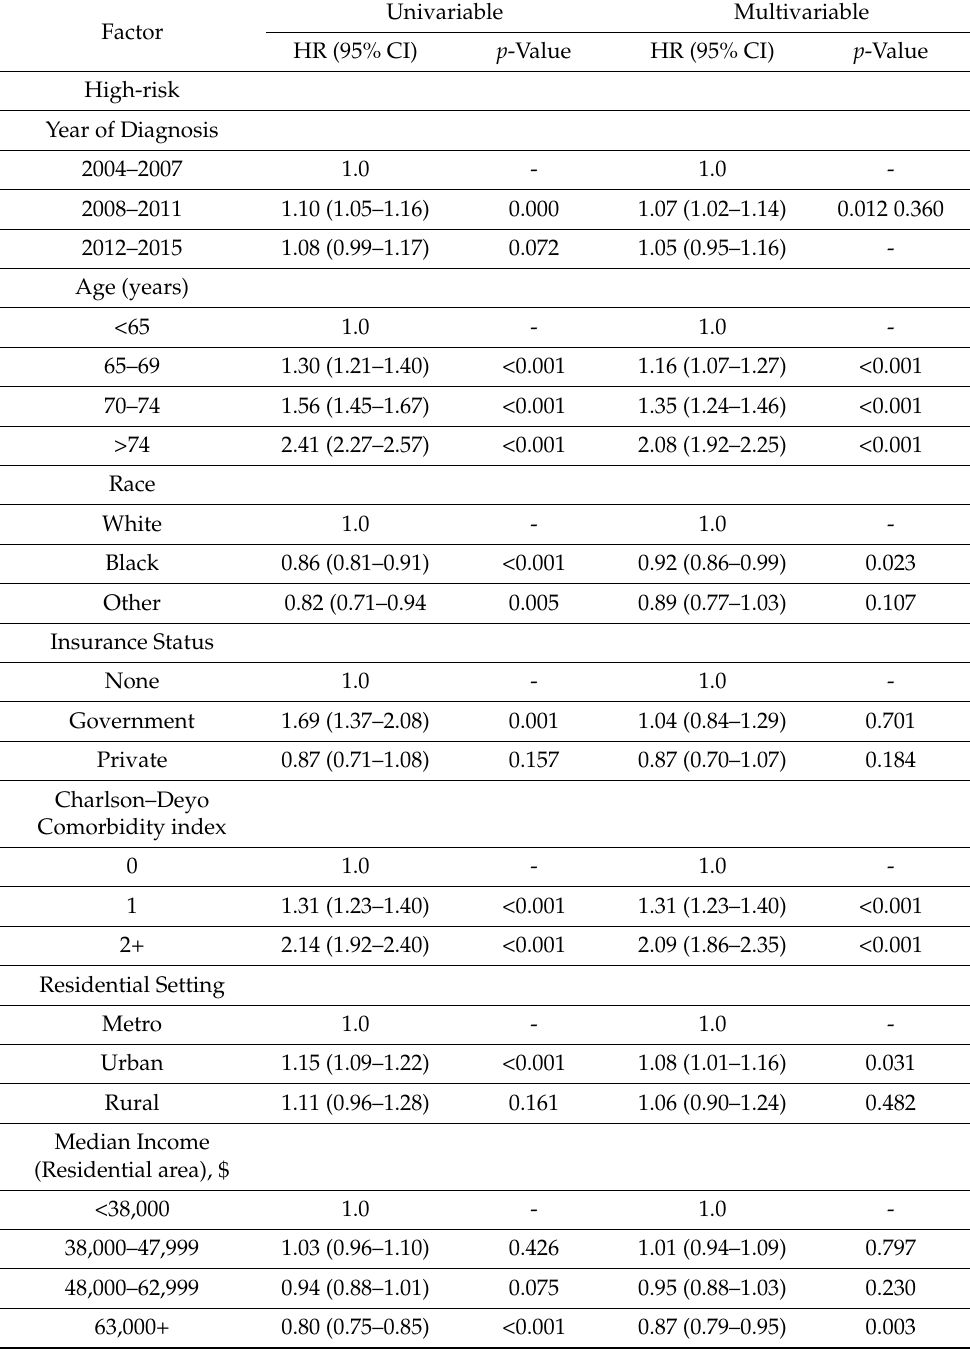
Table 8. Unadjusted and adjusted hazard ratios (HR) for respective univariate and multivariate Cox proportional hazard models of overall survival in high-risk prostate cancer patients who received one of the six